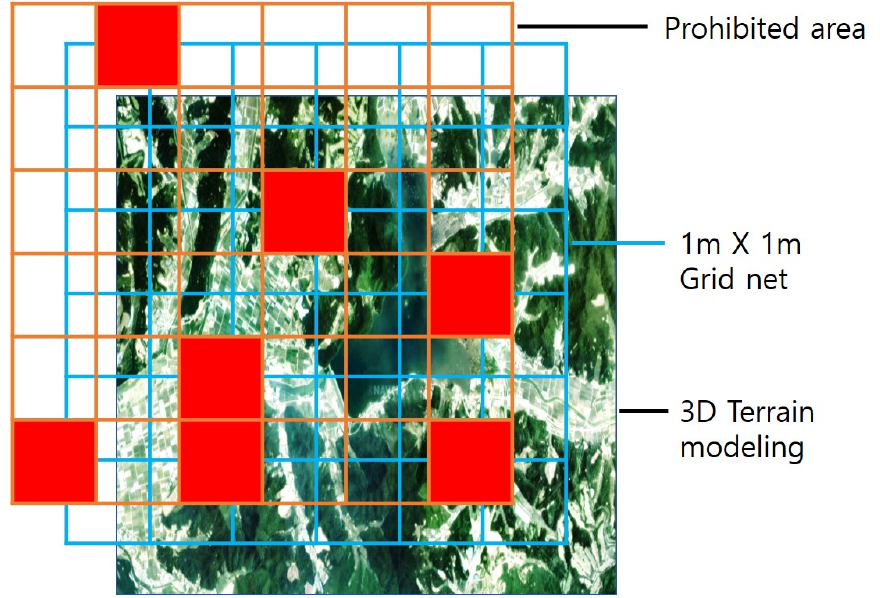
Figure 4. Topographical Modeling with Essential Factors.